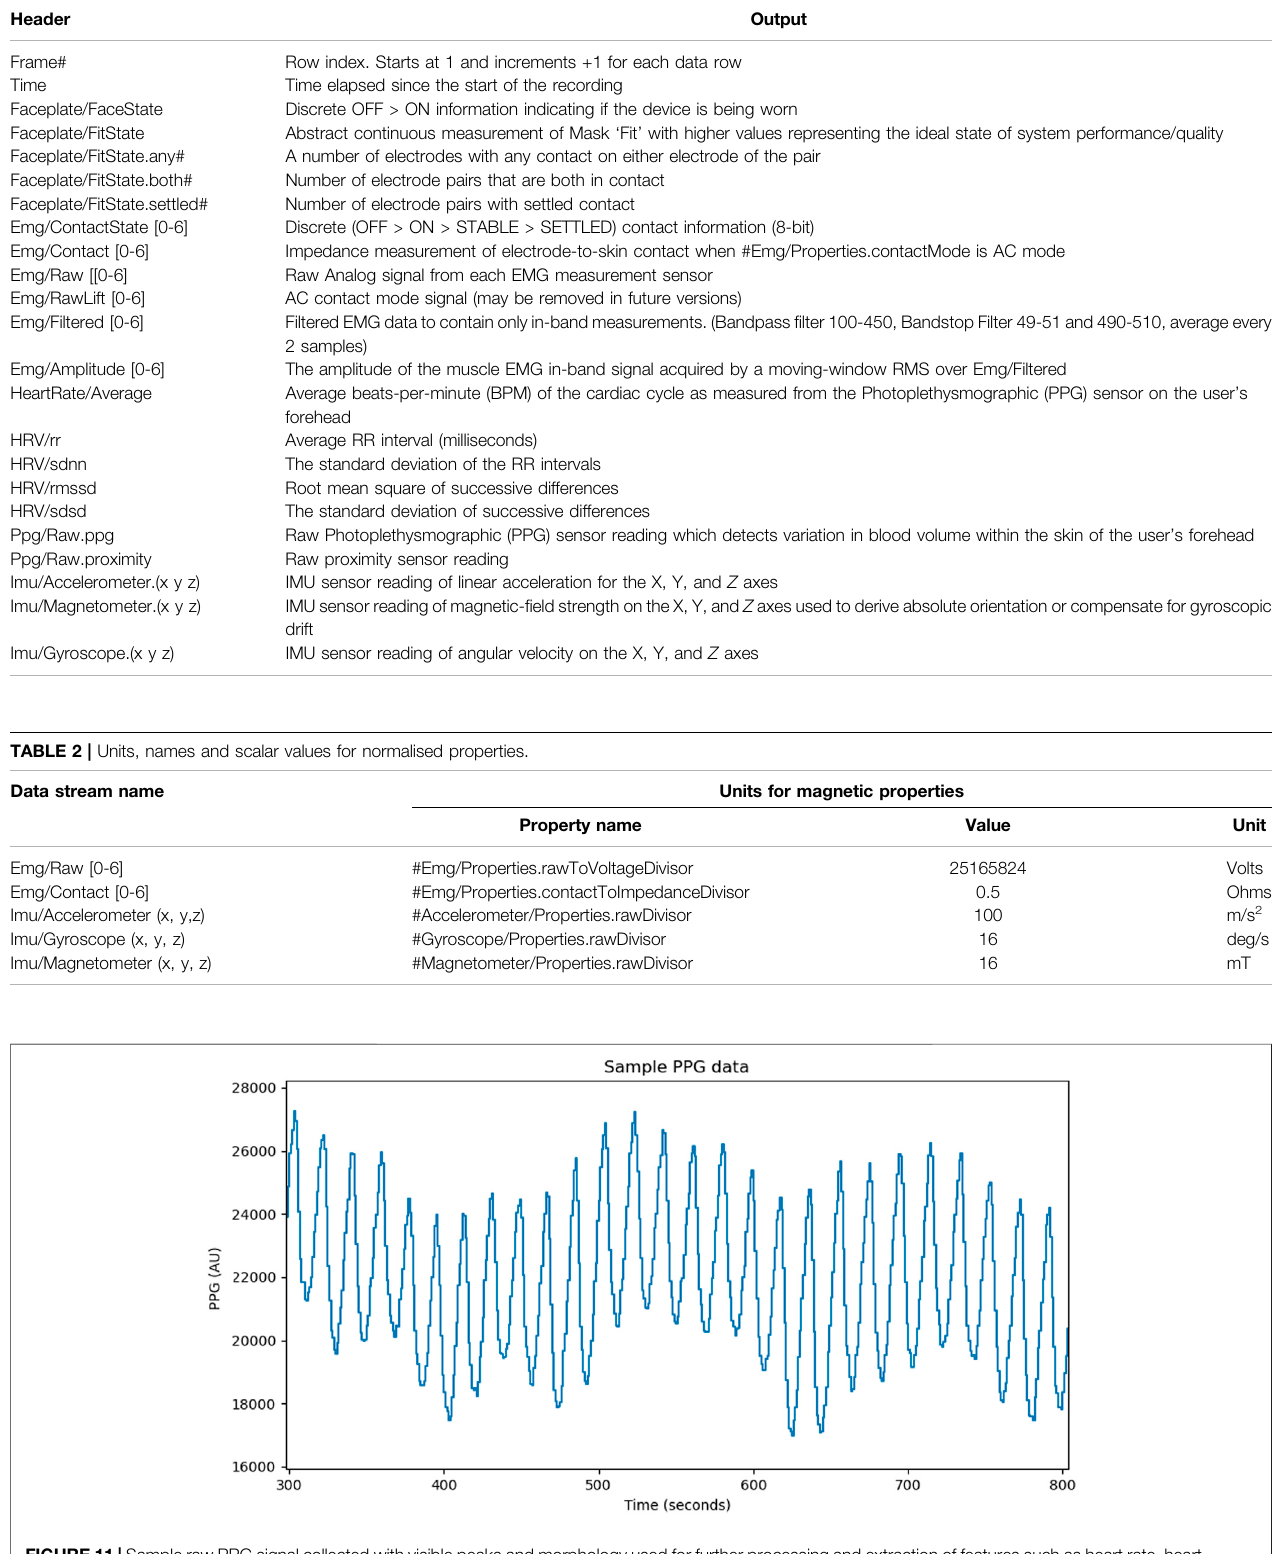
Frontiers in Virtual Reality |